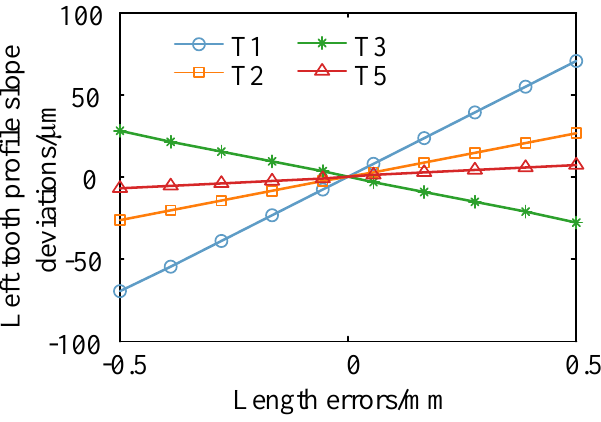
Figure 12. Relationship between tooth profile slope deviations and length errors.